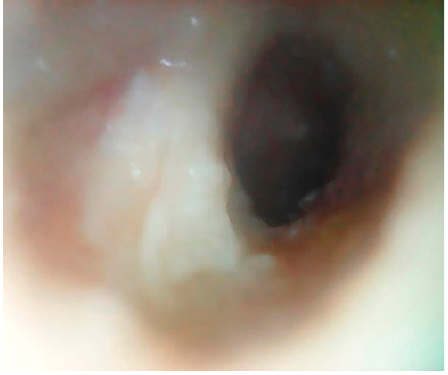
Figure 4. Preoperative image (bone erosion of the EAC inferior wall).